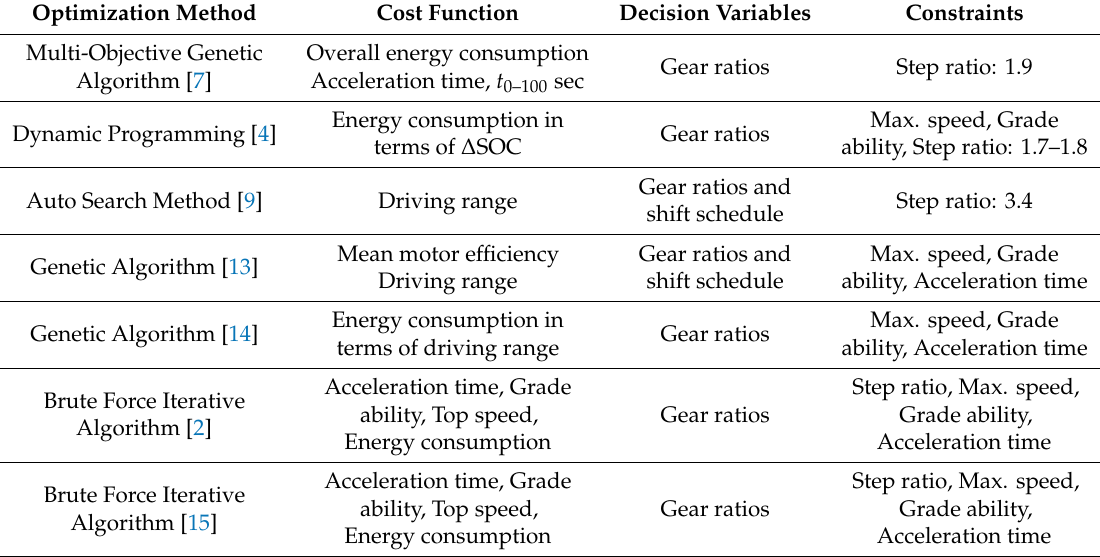
Table 6. Approaches for optimization of gear ratios in the multi-speed transmission system in